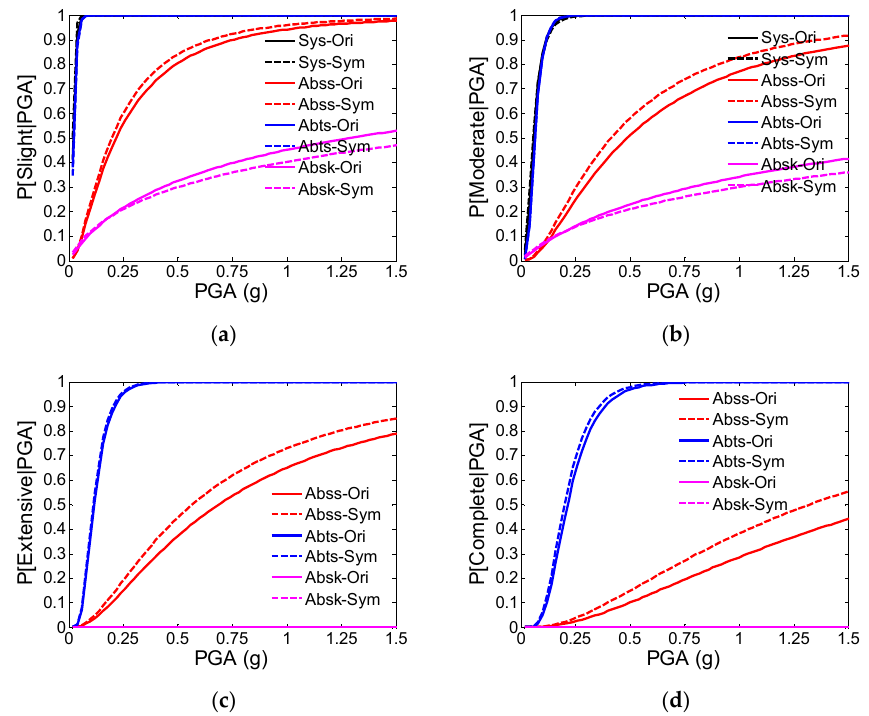
Figure 15. Seismic fragility curves of the bridge system and secondary components for the original model and symmetric model: Abss; Abts; Absk in the ( a ) slight; ( b ) moderate; ( c ) extensive; and ( d ) complete limit states.